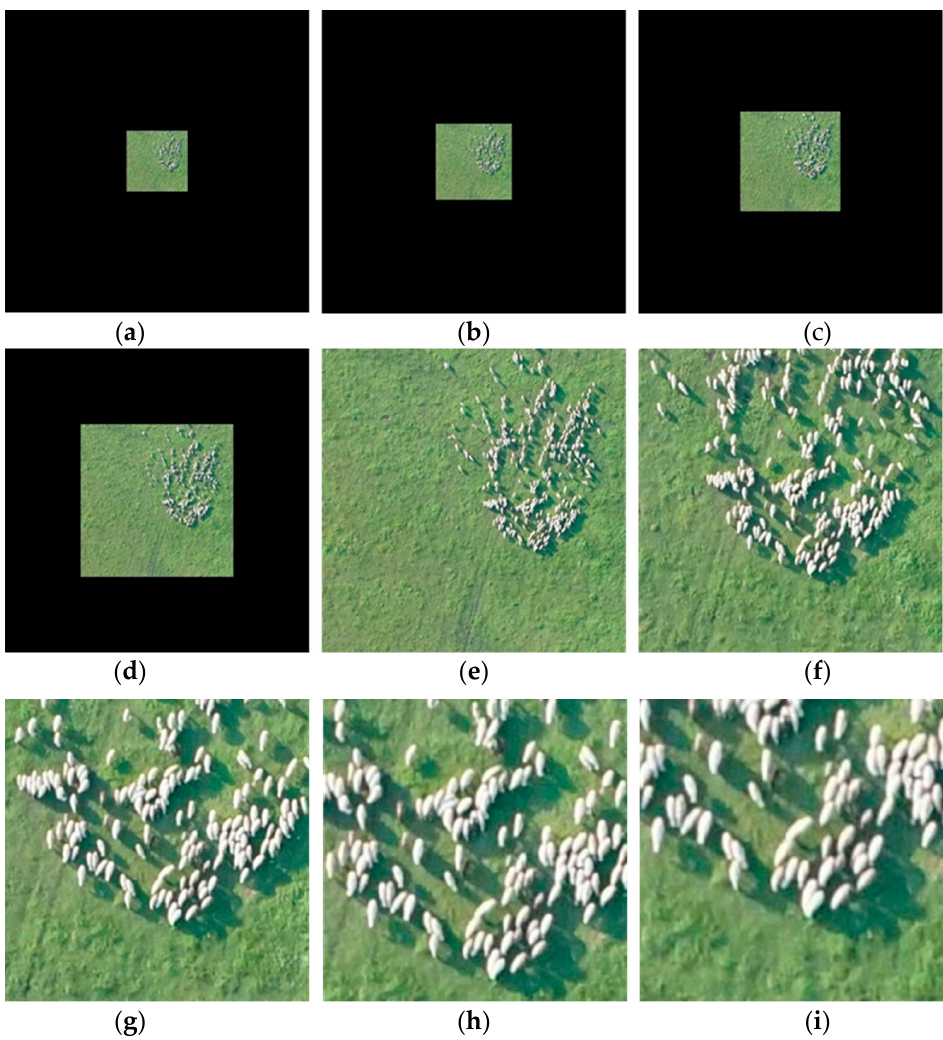
Figure 6. ( a – i ) The display of image patches of scale 0.2-5 in the multi-scale dataset. Among them ( a – d ) are image patches (scale < 1) surrounded by zero values. ( e ) The original image patch (scale = 1); ( f – i ) image patches (scale > 1) which are windows of 1024 × 1024 to intercept the enlarged images.